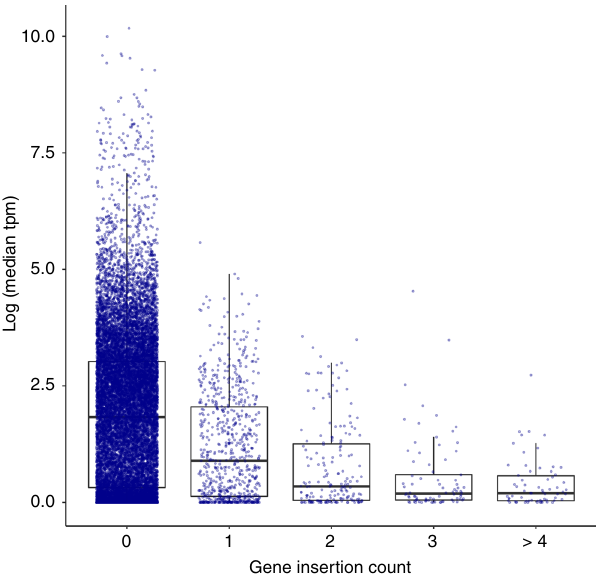
Fig. 2 Retrotransposon insertions in protein-coding genes. Gene expression (median TPM values from 34 tumors) over gene insertion count groups. Boxplot shows median, interquartile range (IQR), and whiskers extend to the most extreme data points which are no more than 1.5 times the IQR Table 1 Genes from the Cancer Gene Census with two or more